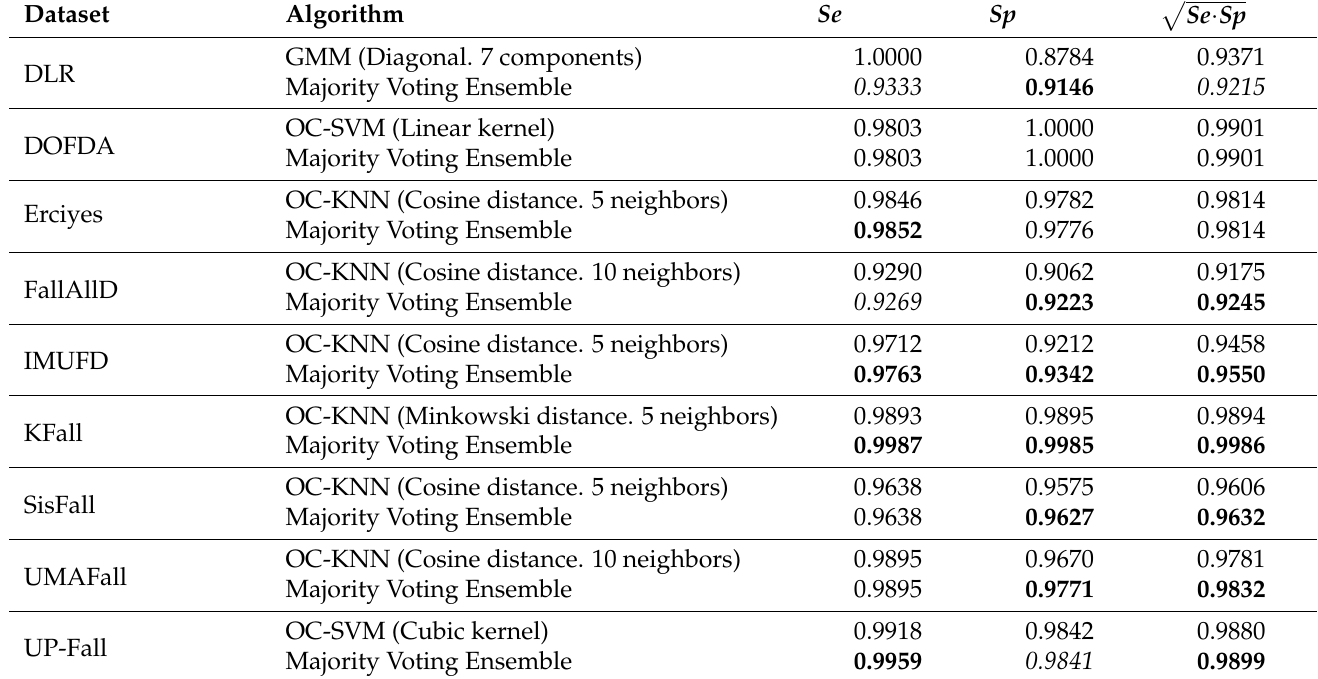
Table 9. Comparison of the performance metrics of the majority voting ensemble and those of the best single OCC. Dataset